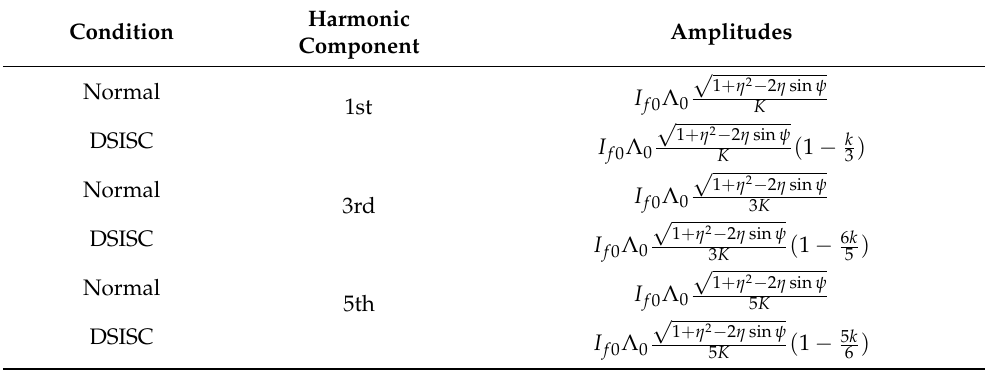
Table 1. Amplitudes Corresponding to Each Harmonic Component of the